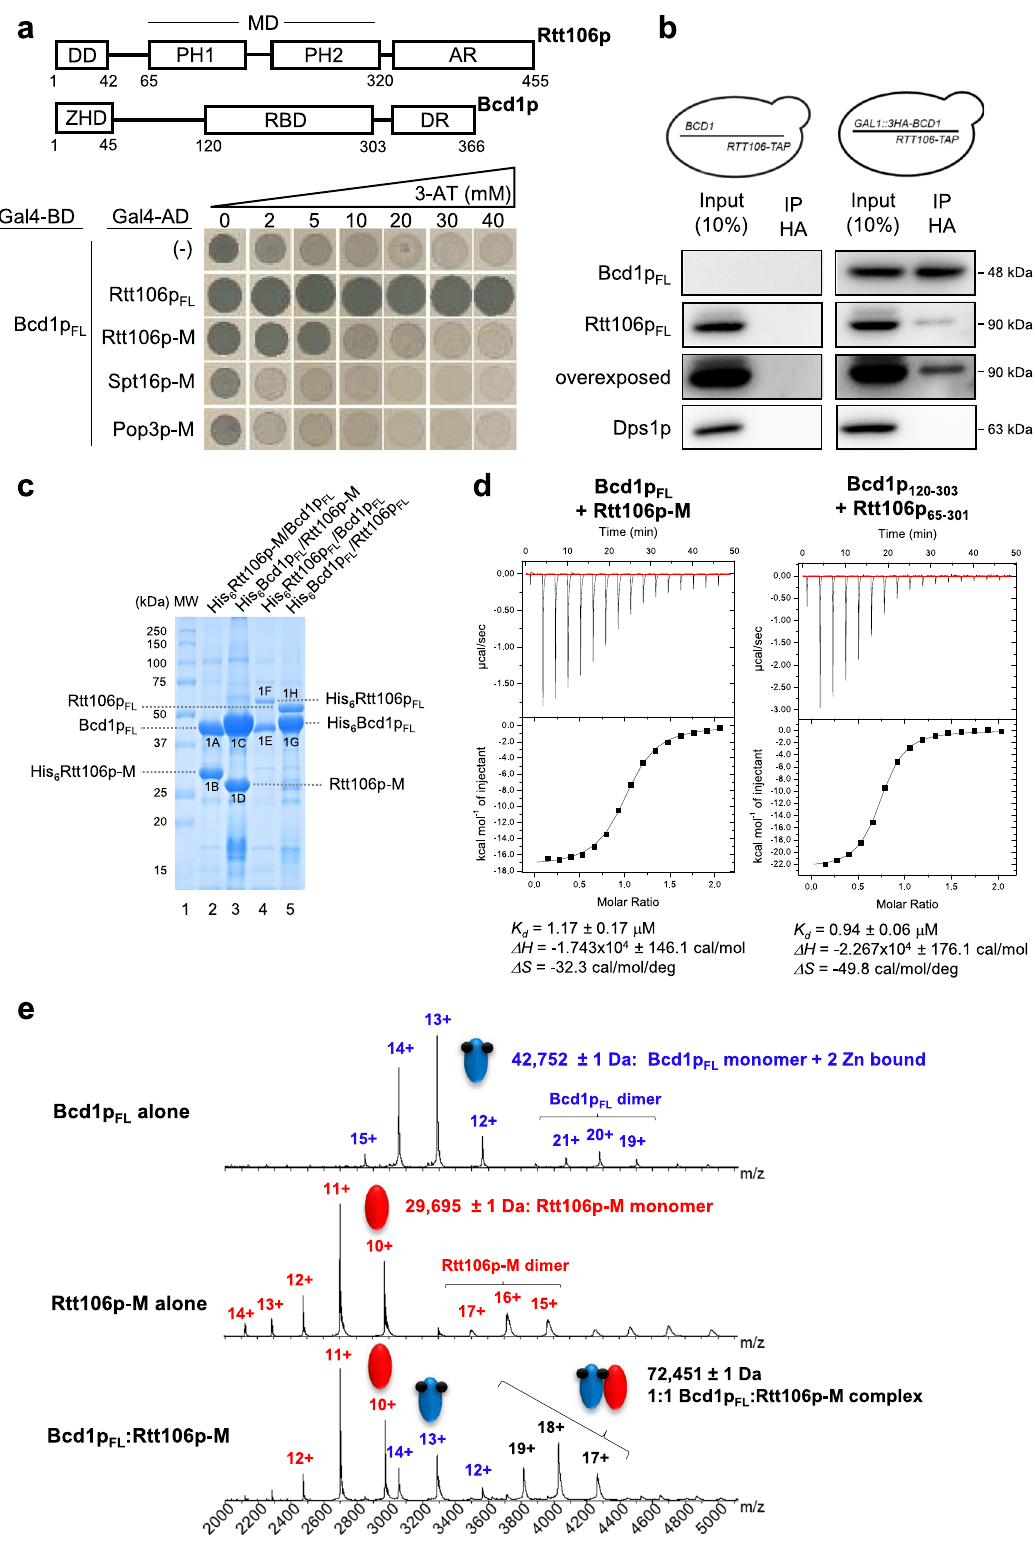
upon heterodimer formation. The IM-MS measured TW CCS N2 (44.4 ± 1.4 nm 2 ) was larger than the value expected from mass and 15% smaller than the one predicted from a juxtaposition of the two subunits. We concluded that the heterodimer is not formed merely by simple juxtaposition of the two